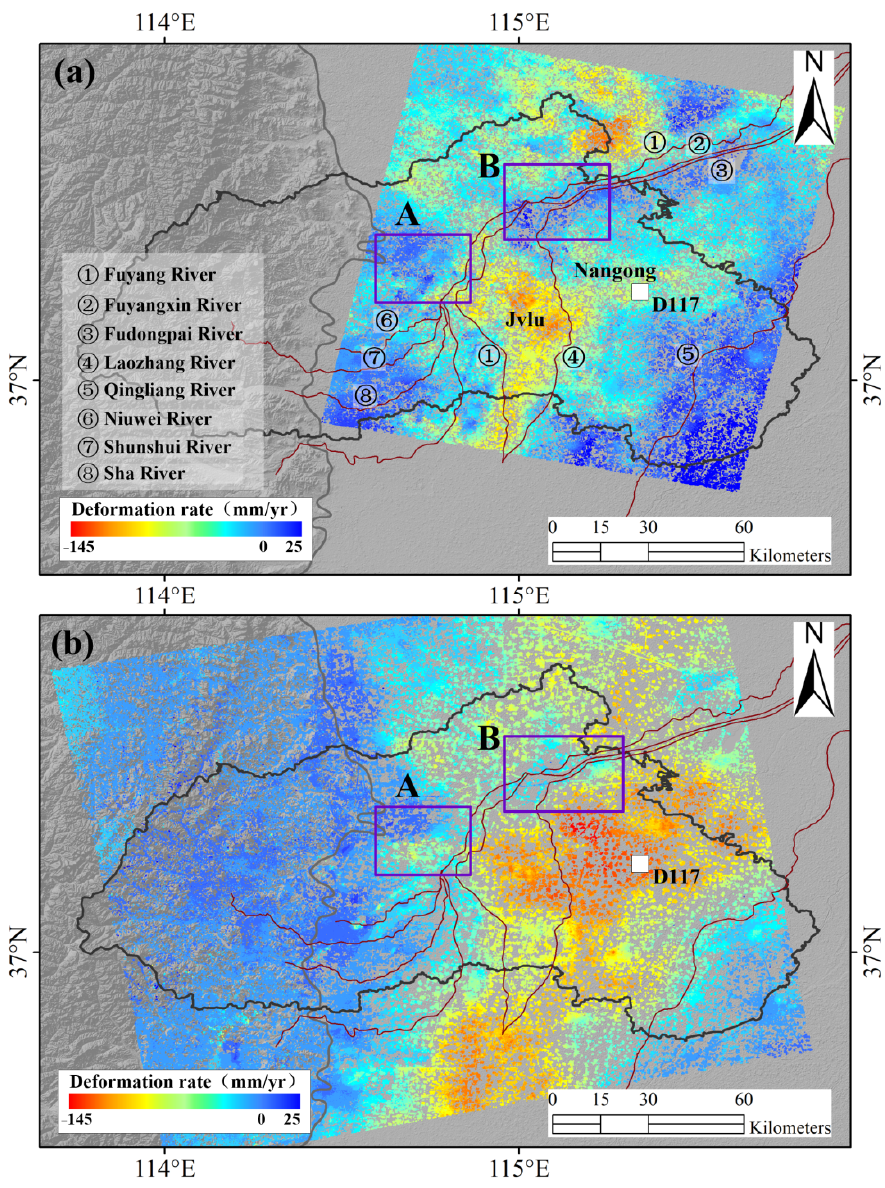
Figure 3. The mean-deformation-rate maps over Xingtai during ( a ) 2009~2010 and ( b ) 2015~2021. The brown lines mark the rivers. The white squares represent observation well, of which displacement time series is compared with head changes in Figure 4. The purple boxes, labeled as A and B, mark the zones which are analyzed in Section